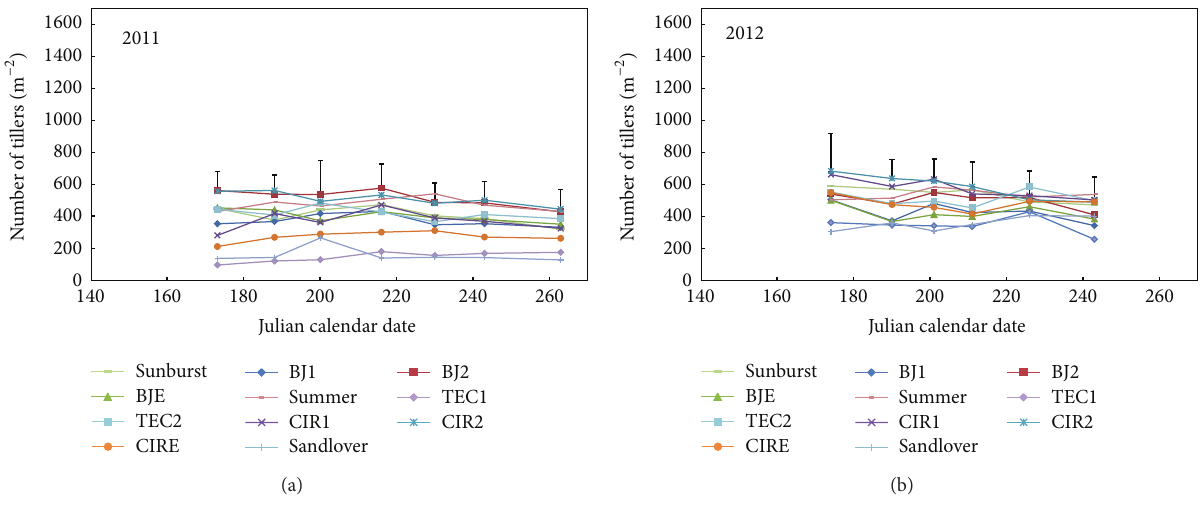
Figure 2: Number of tillers m −2 of 11 selections of switchgrass at Cookshire-Eaton, Quebec, in 2011 and 2012. Vertical bars represent the least significant difference (LSD, 𝑃 = 0.05 ) at each sampling point throughout the season. BJ1, Blue Jacket; BJ2, Blue Jacket II; BJE, Blue Jacket Early; TEC1, Tecumseh; TEC2, Tecumseh II, CIR; Cave-in-Rock; CIR2, Cave-in-Rock II; CIRE, Cave-in-Rock